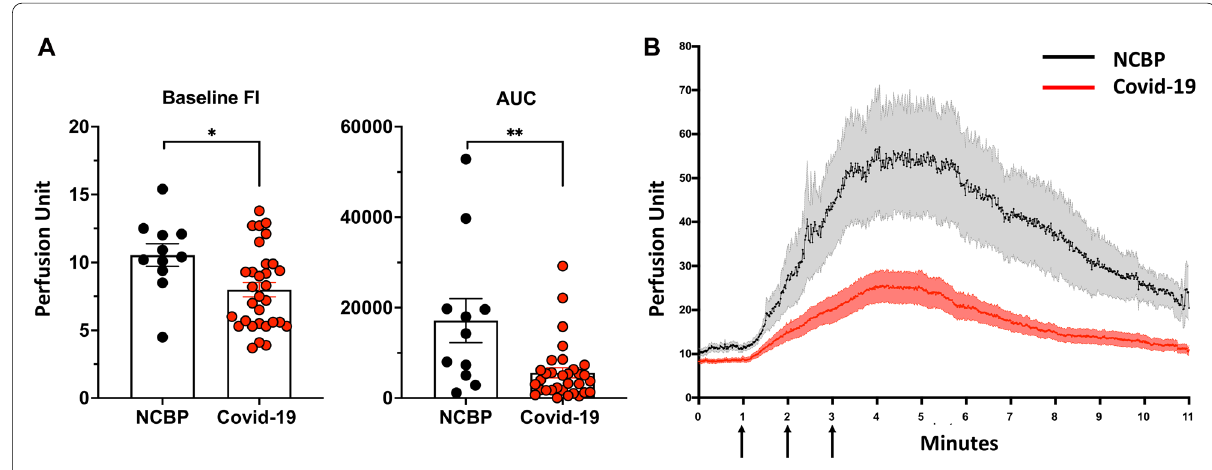
Fig. 1 A Skin microvascular endothelial flow at baseline and reactivity defined by area under the curve in non‑COVID‑19 bacterial pneumonia (NCBP) and COVID‑19 patients. B Skin microvascular blood flow in response to three stimulation of acetylcholine (arrows) in NCBP patients (grey) and COVID‑19 patients (red), represented as mean / SEM every second for 10 min after the first acetylcholine +